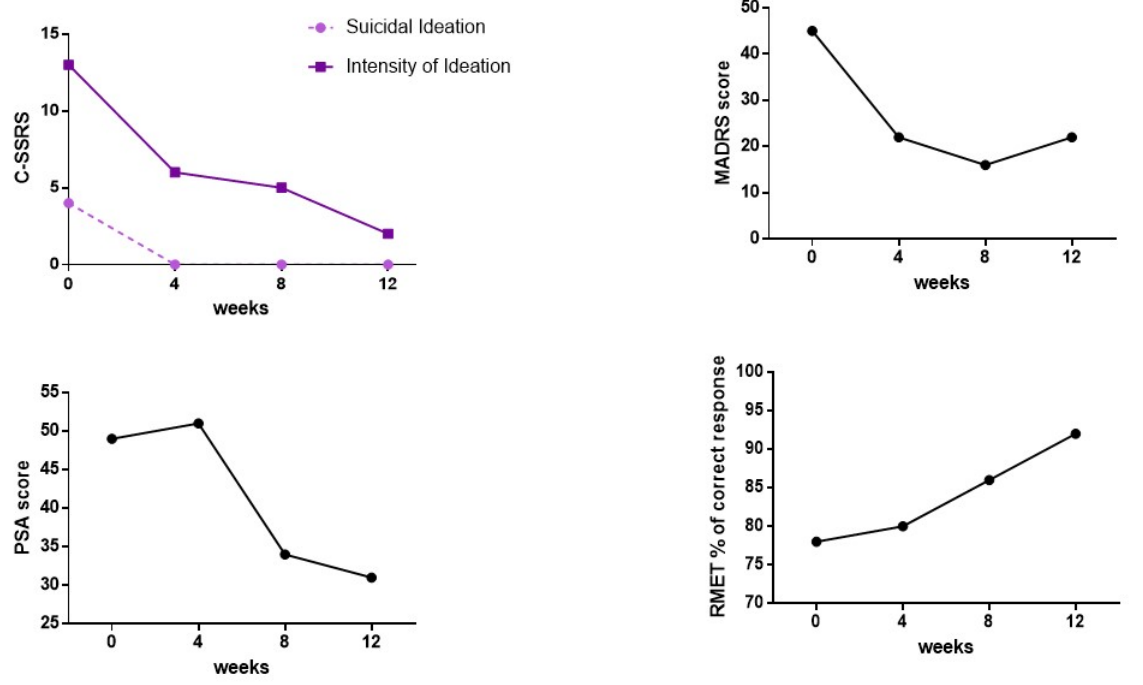
Figure 1: C-SSRS, MADRS, PSA total scores and RMET percentage of correct responses at baseline and at the different